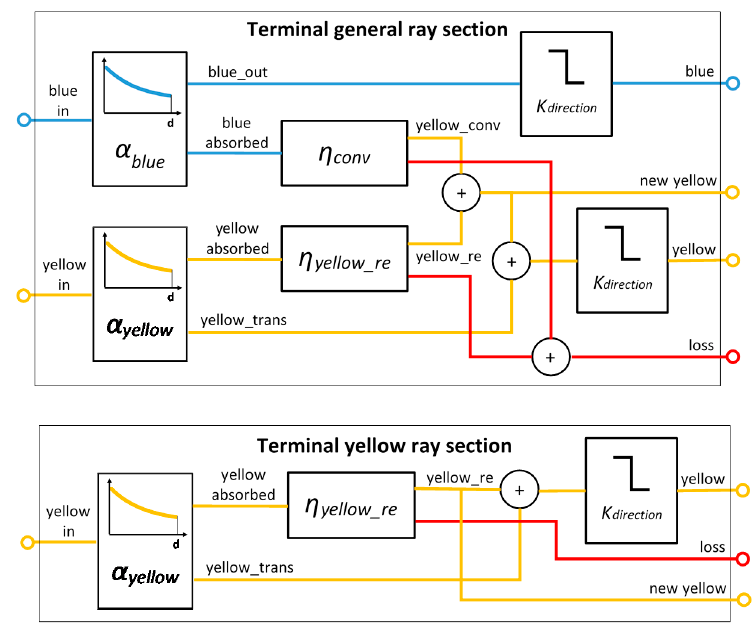
Figure 21. Structure of the terminal ray sections.